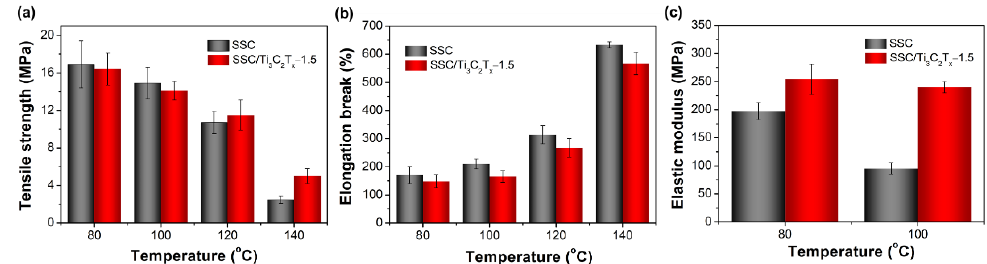
Figure 9. Mechanical properties of SSC and SSC/Ti 3 C 2 T x -1.5 composite membranes under different temperatures. ( a )Tensile strength and ( b ) elongation break of membranes under 80 °C, 100 °C, 120 °C and 140 °C; ( c ) elastic modulus of membranes under 80 °C and 100 °C.